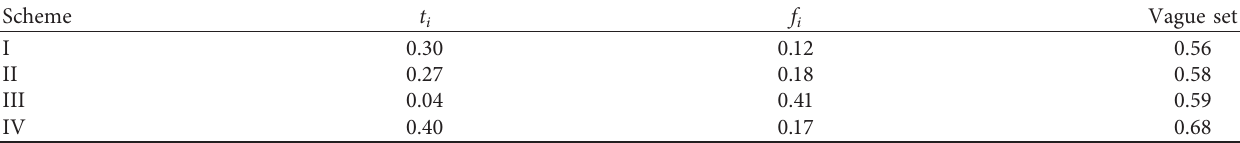
Table 5: The corresponding values in vague set theory.